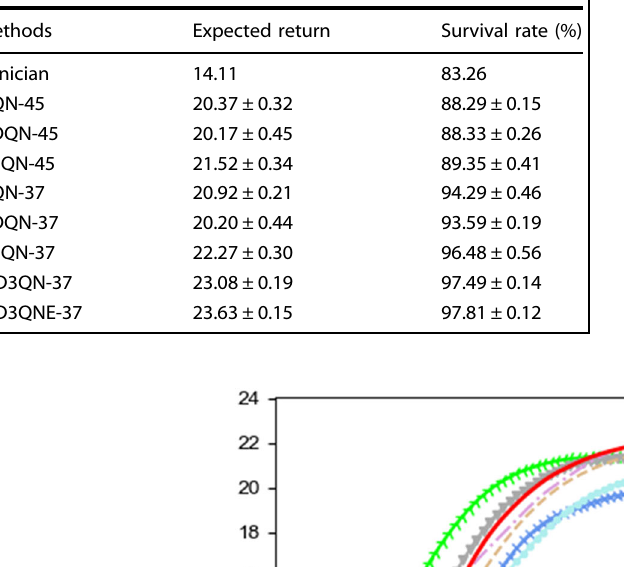
Table 1. Off-policy evaluation performance of baselines in the test set.